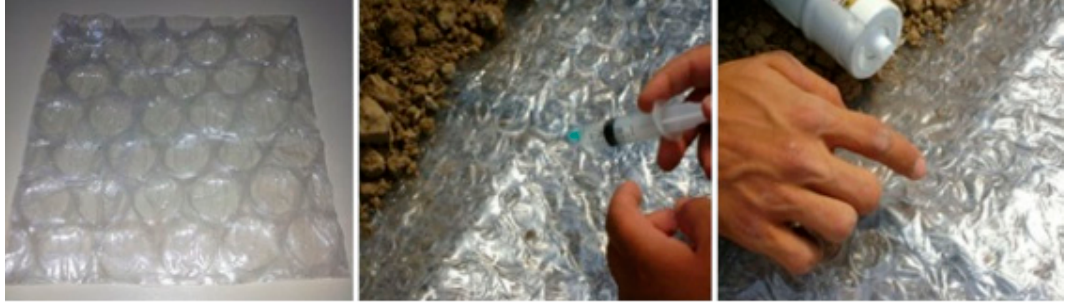
Figure 2. Surface modification of mulching PE materials [38].